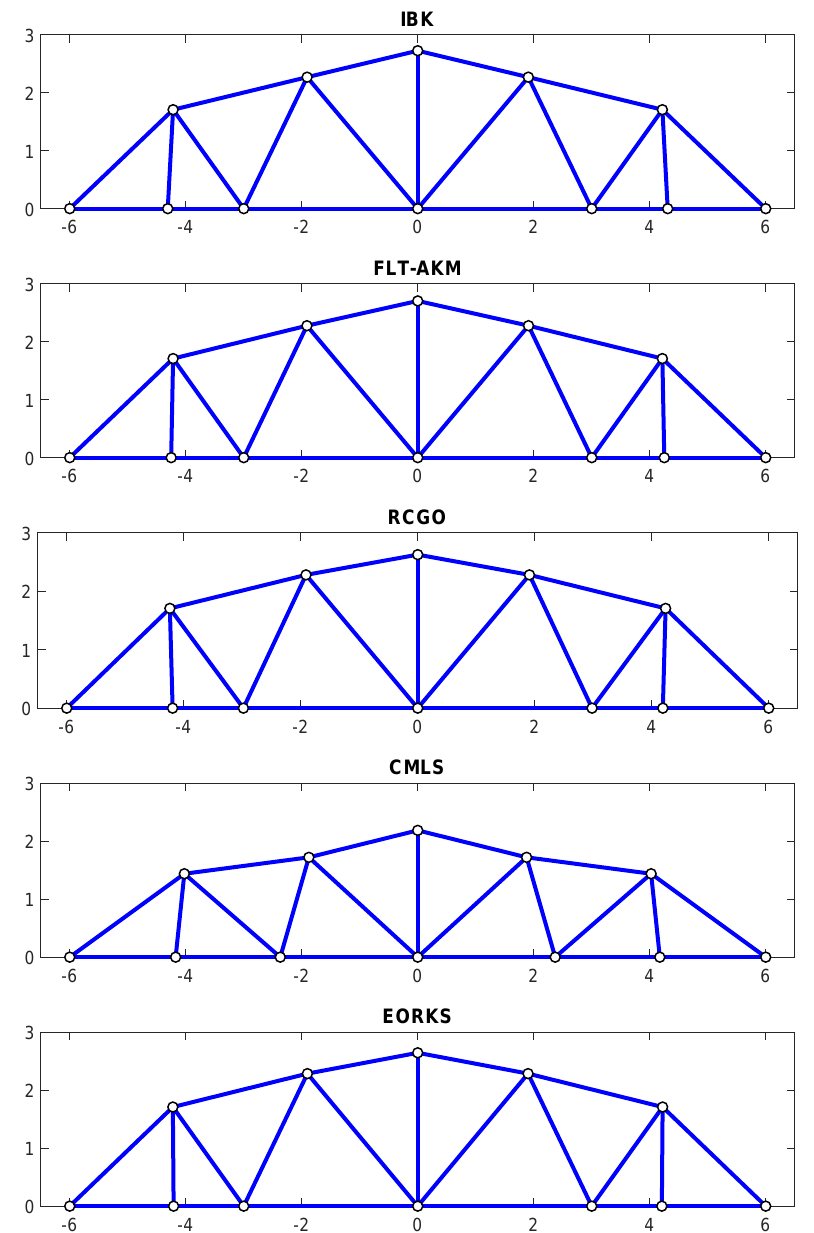
Figure 6. Comparison of optimal shapes of the 21-bars planar truss obtained by